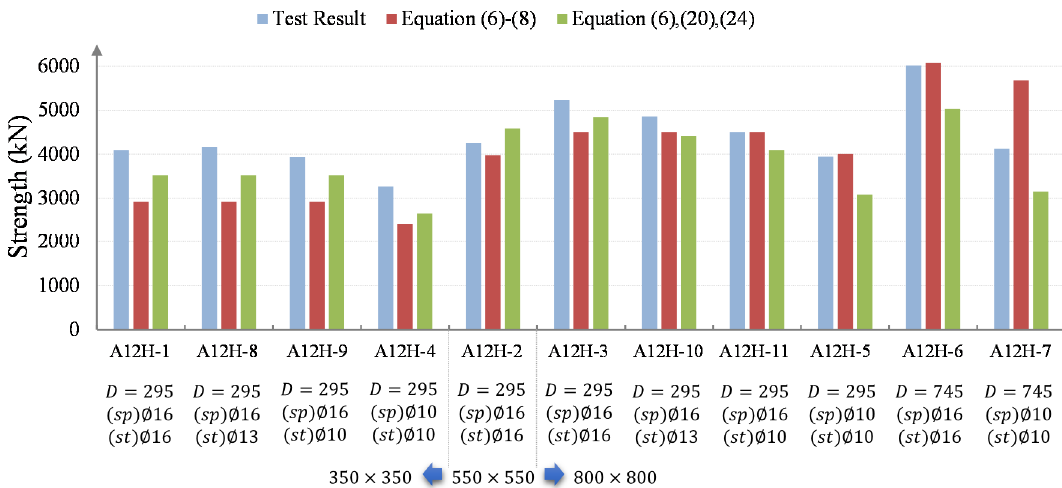
Figure 12. Comparison of test results and results of design equations.